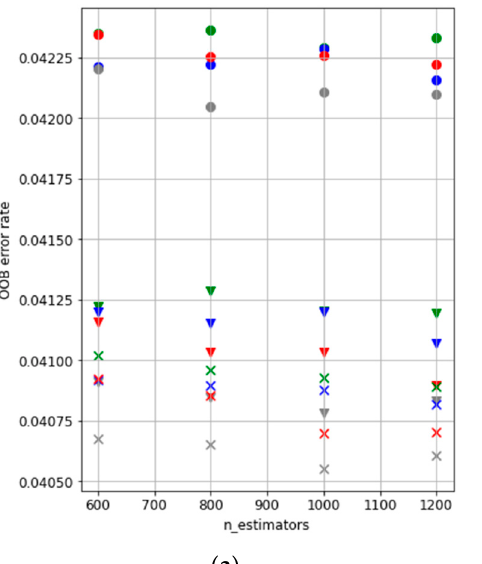
Table 3. Confusion matrix for RF-OS model with the test